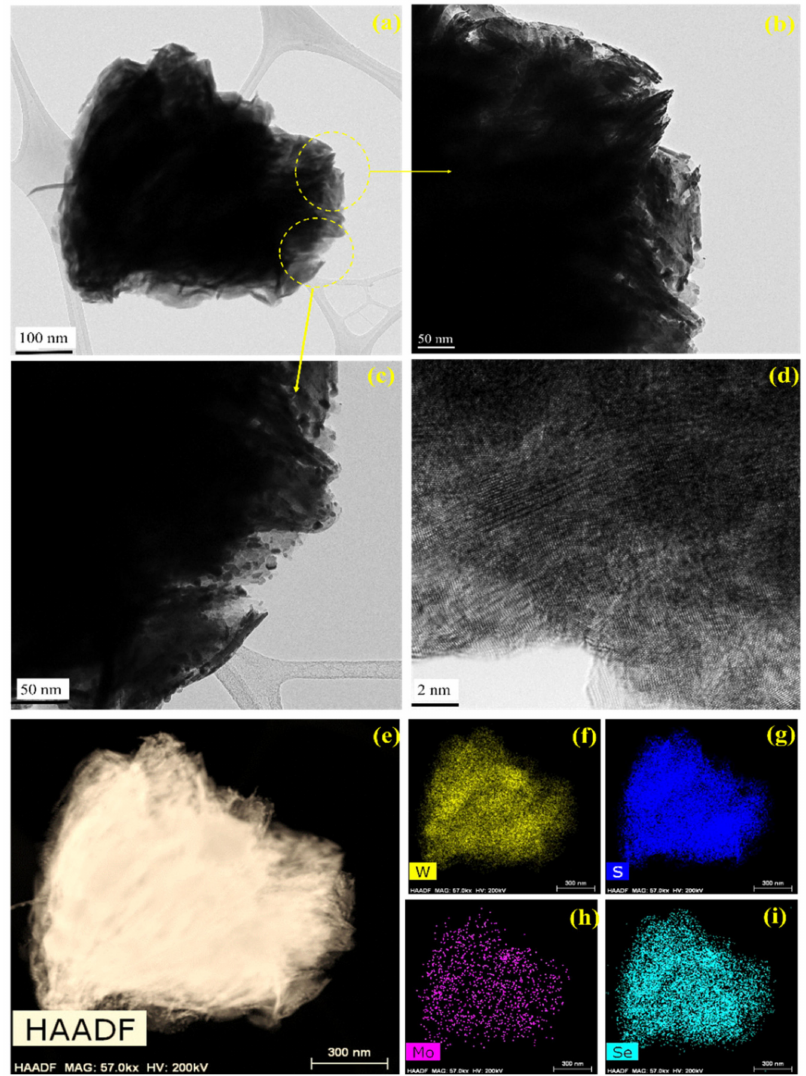
Figure 2. ( a – c ) TEM images of the MoSe 2 -WS 2 nanocomposite, ( d ) HRTEM image, ( e ) HAADF-STEM pattern, and ( f – i ) corresponding elemental mapping images of W, S, Mo and